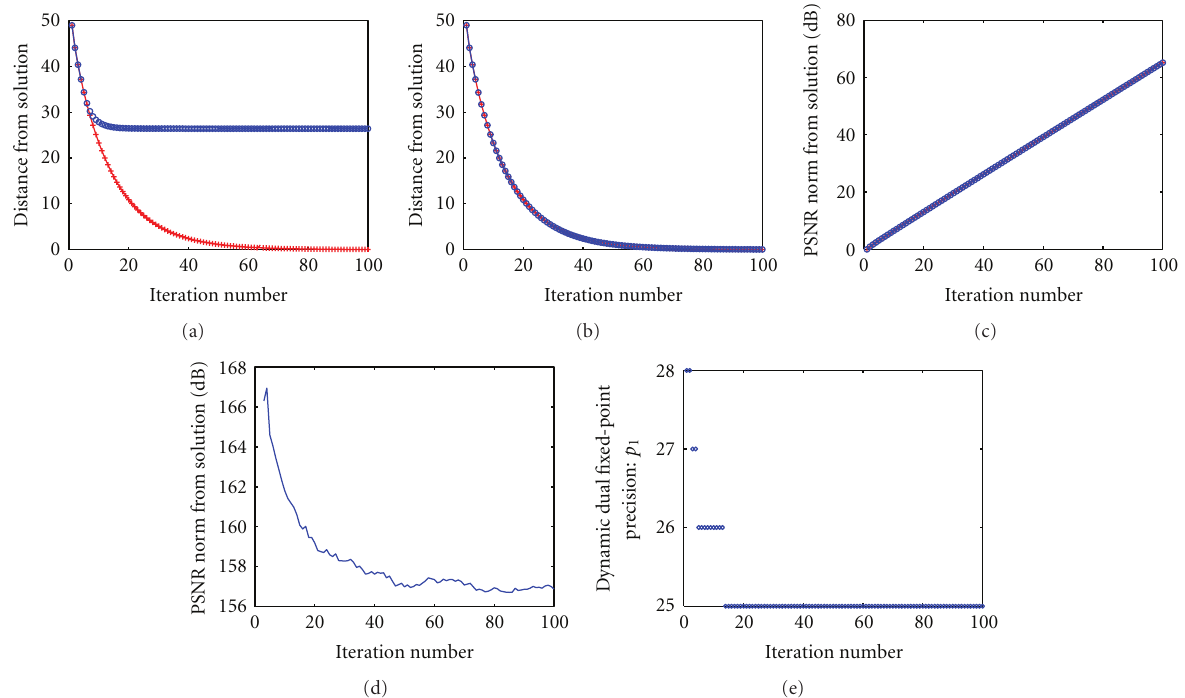
Figure 17: Comparisonof DDFX to DFX and double-precision floating-point solutions.(a) Euclidean distance of the DFX (plotted with blue circles) and double-precision floating point (plotted with red “+”) from the actual solution as a function of the iteration number. Note the lack of convergence of the standard DFX method. (b) Euclidean distance of DDFX (plotted with blue circles) and double-precision floating point (plotted with red “+”) from the actual solution as a function of the iteration number. The DDFX approach converges at the same rate as double-precision floating point. (c) Replot of (b) where Euclidean distance from the solution is measured in dB. The double-precision floating-point and DDFX solutionsare indistinguishable in this graph. The blue circles of DDFX overlap with the red “+” of double-precision floating point. (d) PSNR of the distance from the DDFX iterate to the double-precision floating-point iterate. The high PSNR values indicate that the two solutions are virtually identical. (e) Dynamic adjustment of p 1 as a function of the iteration ( n = 32, p 0 = 29). These results were obtained through simulations.